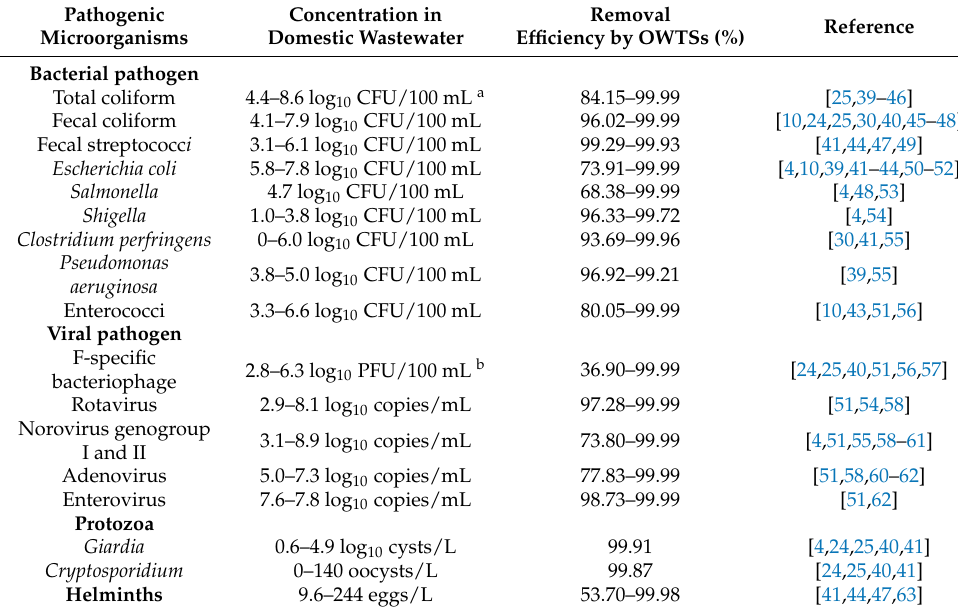
Table 1. The concentrations of indicator pathogens in domestic